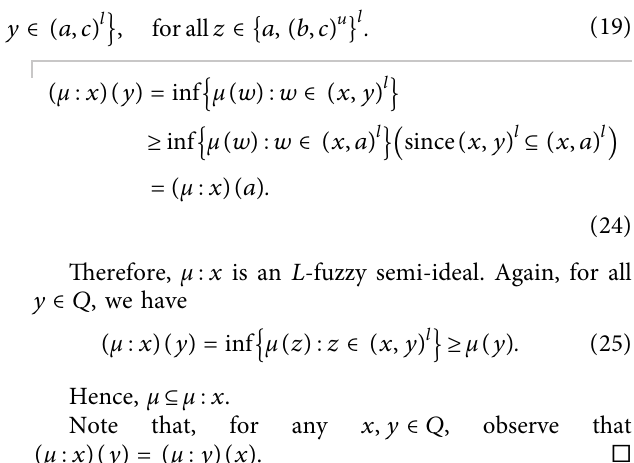
Figure 1: An L -fuzzy semi-prime ideal which is not an L -fuzzy prime ideal of Q